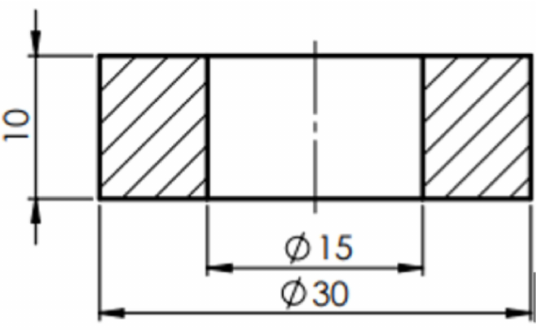
Figure 6. The dimensions of the ring sample. The results of the experiments are presented in Figure 7.